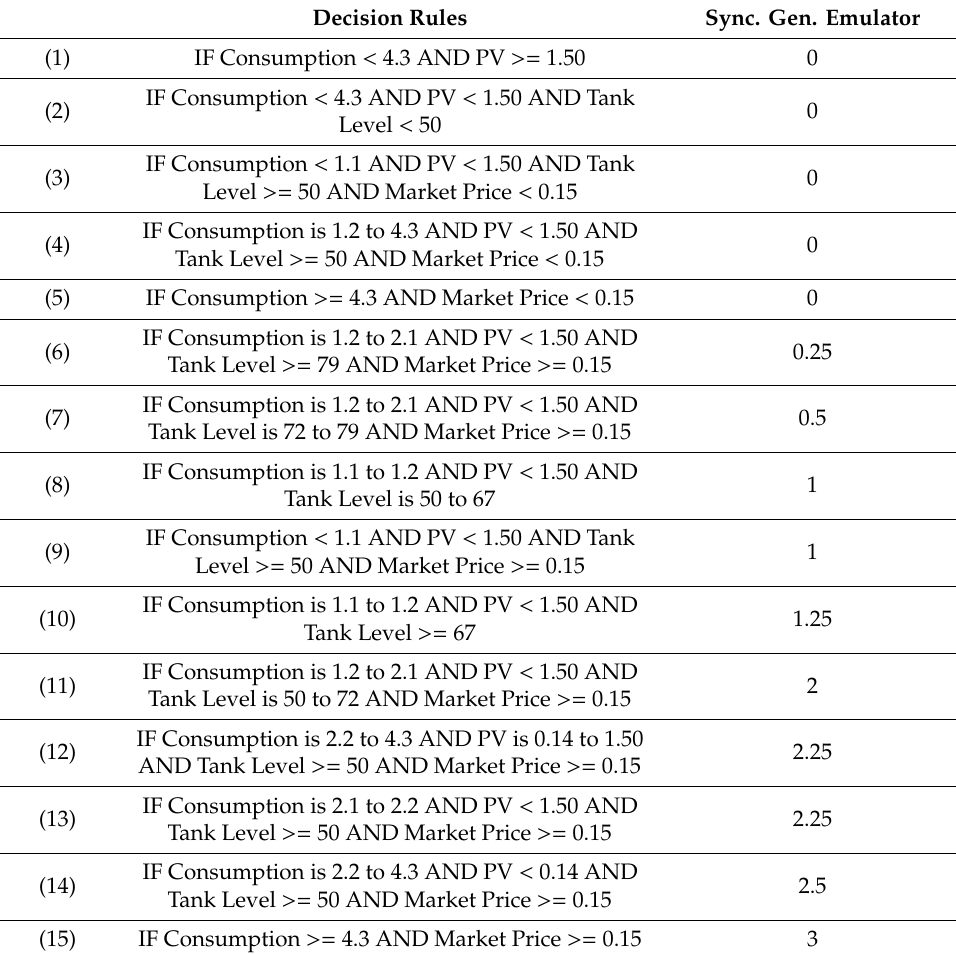
Table 3. Employed decision rules to produce the